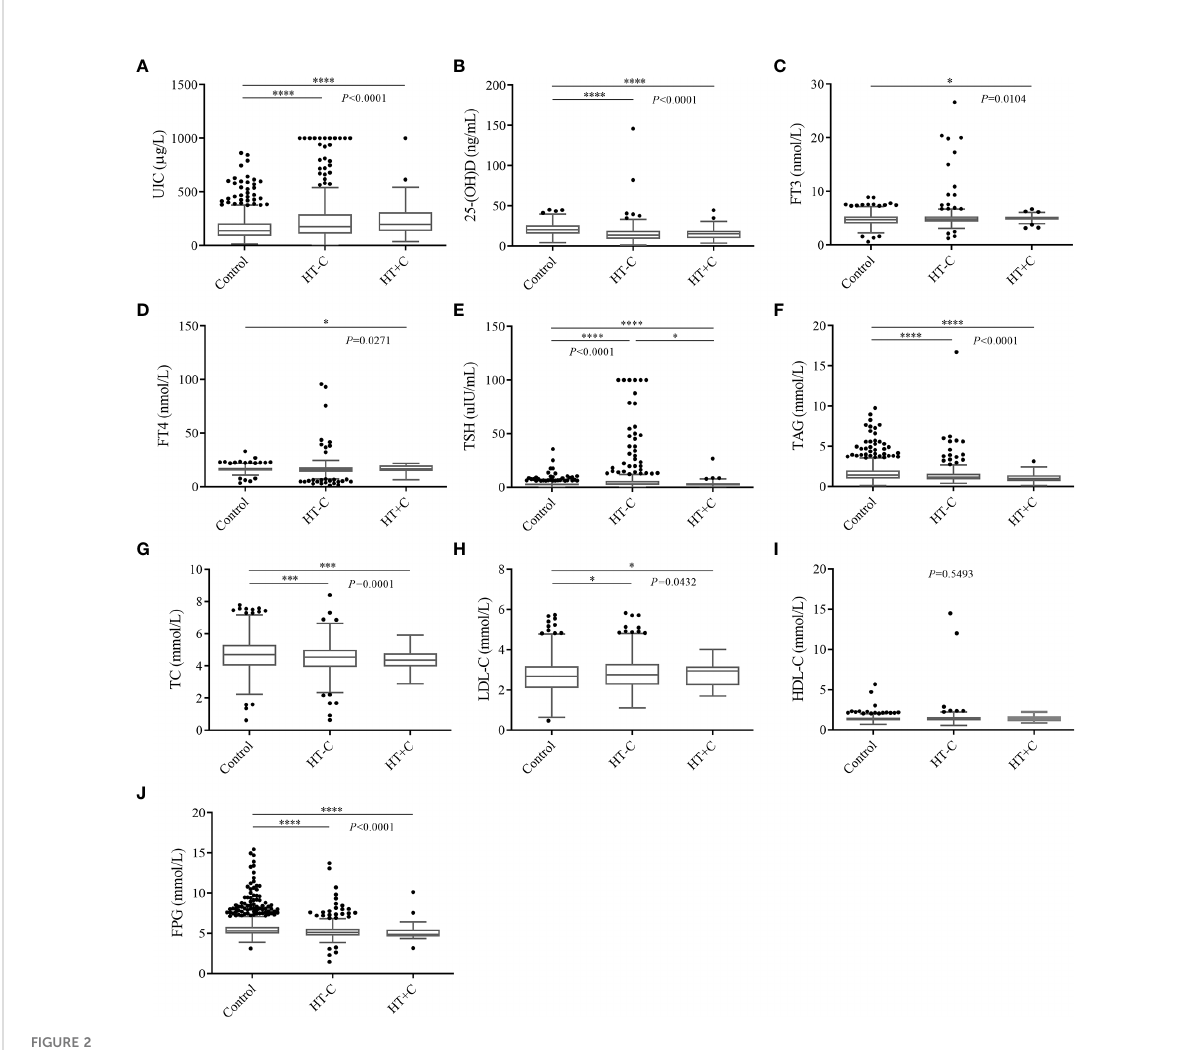
FIGURE 2 Multiple comparative analysis testing of laboratory data among controls and HT patients. (A) UIC, (B) 25-(OH)D, (C) FT3, (D) FT4, (E) TSH, (F) TAG, (G) TC, (H) LDL-C, (I) HDL-C, (J) FPG. * P < 0.05, *** P < 0.001, **** P < 0.0001. UIC, urinary iodine concentrations; 25-(OH)D, 25